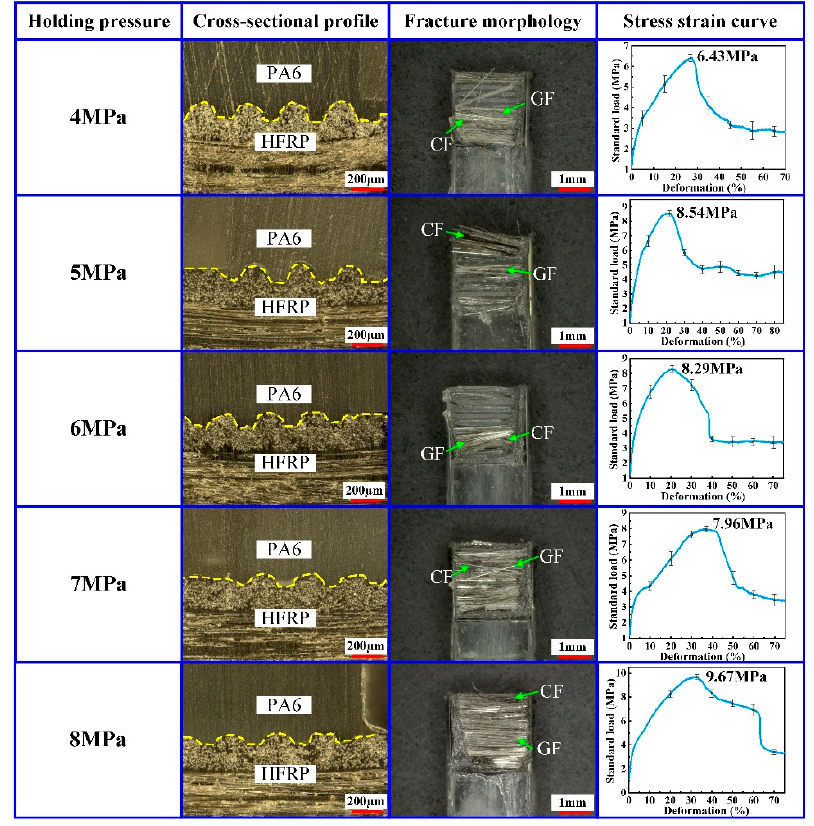
Figure 5. Effect of the holding pressure on the injection molding quality of composite parts.